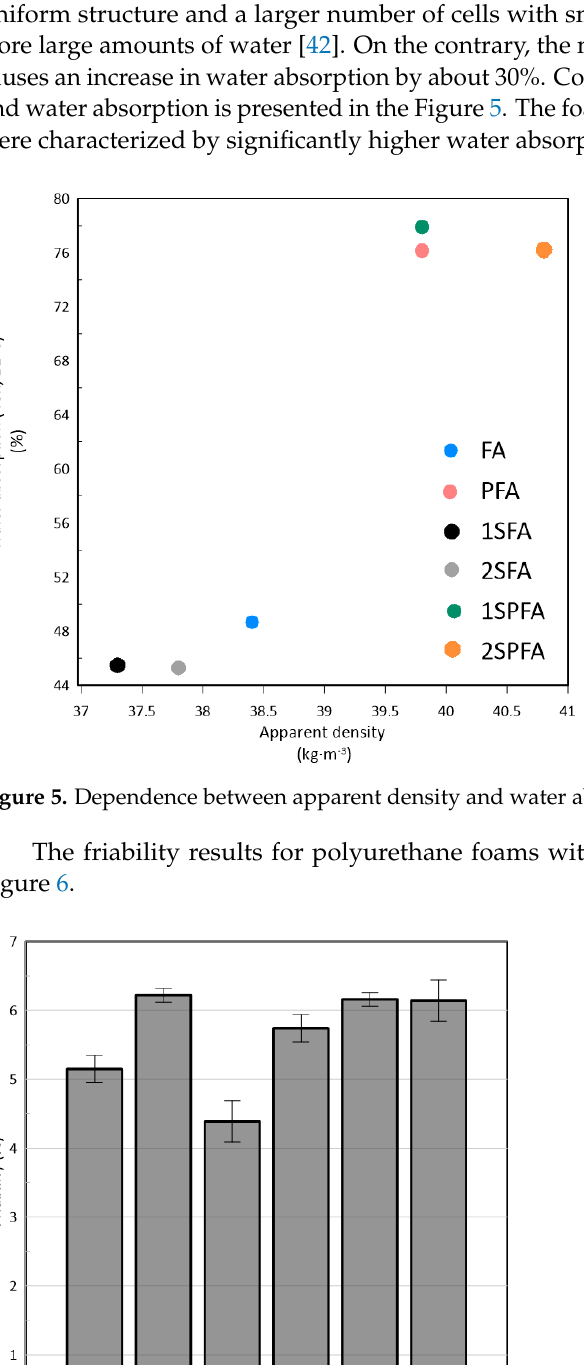
Table 4. Characteristics of thermal degradation of the PU composites.